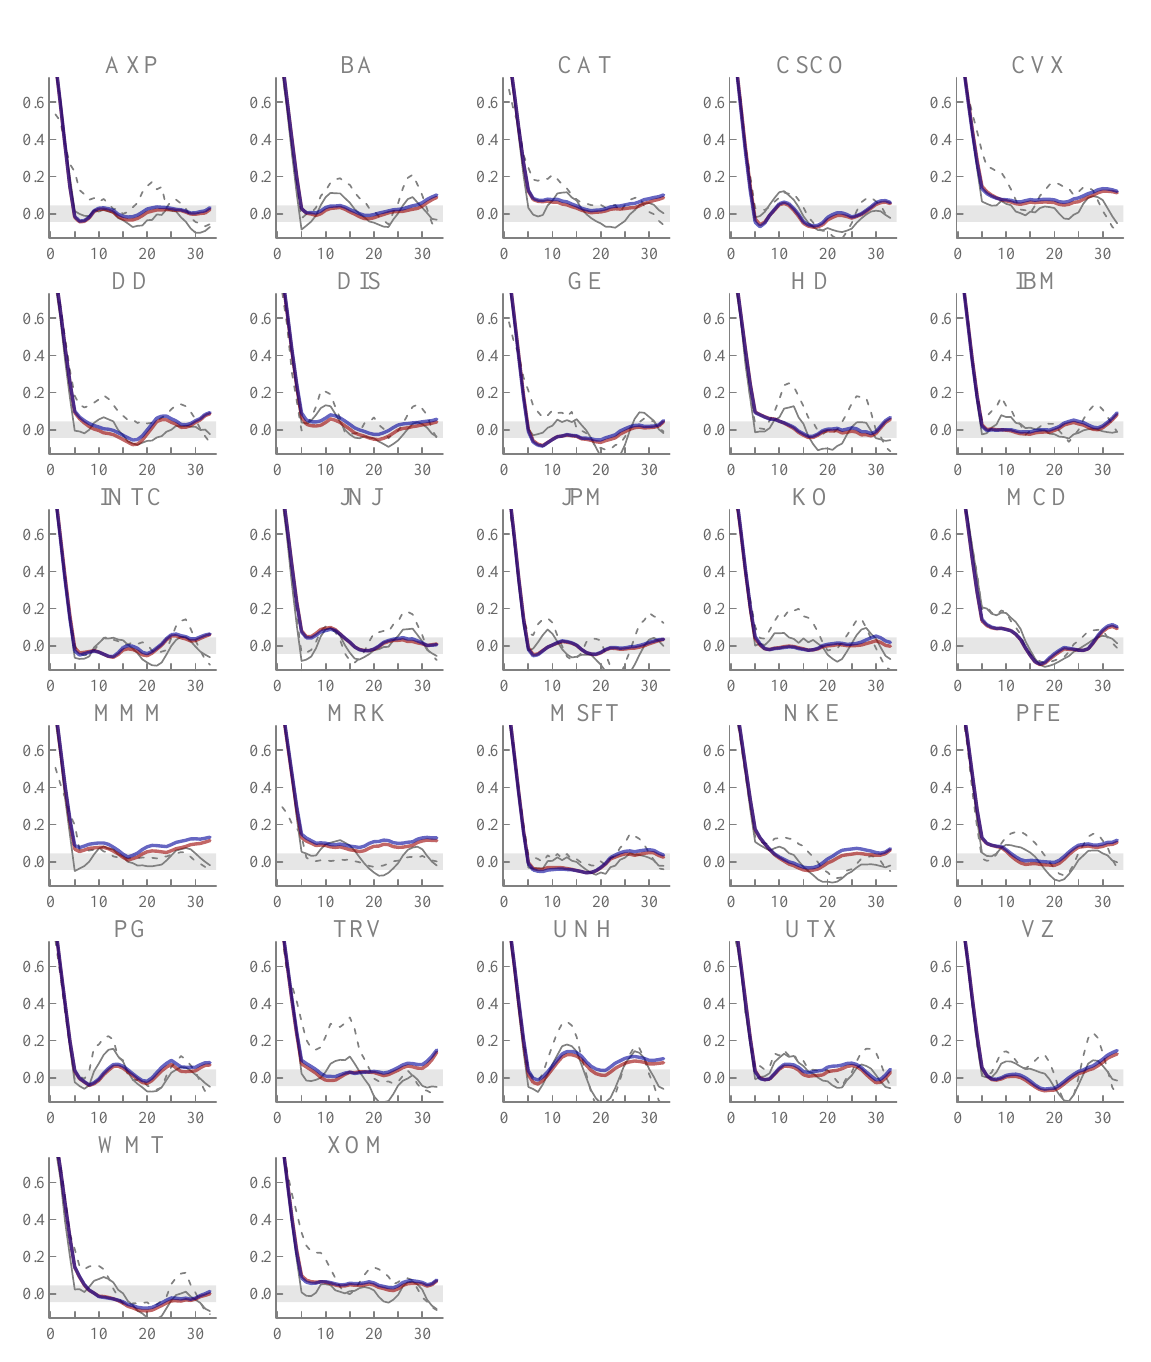
− (cid:98) y ( h ) Figure A3. Autocorrelations of forecast errors e t = y h for stepsize h = 5 days. The autocorre- √ t t RV (gray), for HARQ with y = RV (dashed gray), and for RQ -in-mean lations for HAR with y = √ RV (blue) should all be white noise if e t is iid . with log of average RV (red) and with log of average The gray shaded area is the two standard error band for a white noise series. The rolling forecasts are generated with a rolling estimation window of 8.67 years (104 months) followed by a one month prediction window shifted each month over 96 windows. The forecast sample is from 3 January 2006 to 31 December 2013 (2013 trading